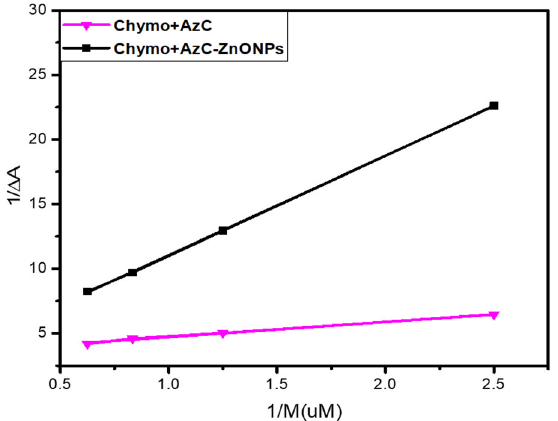
Figure 3. Benesi ‐ Hilderbrand Plot of Chymo+AzC alone and Chymo+AzC ‐ ZnONPs complex. Figure 3. Benesi-Hilderbrand Plot of Chymo+AzC alone and Chymo+AzC-ZnONPs complex.